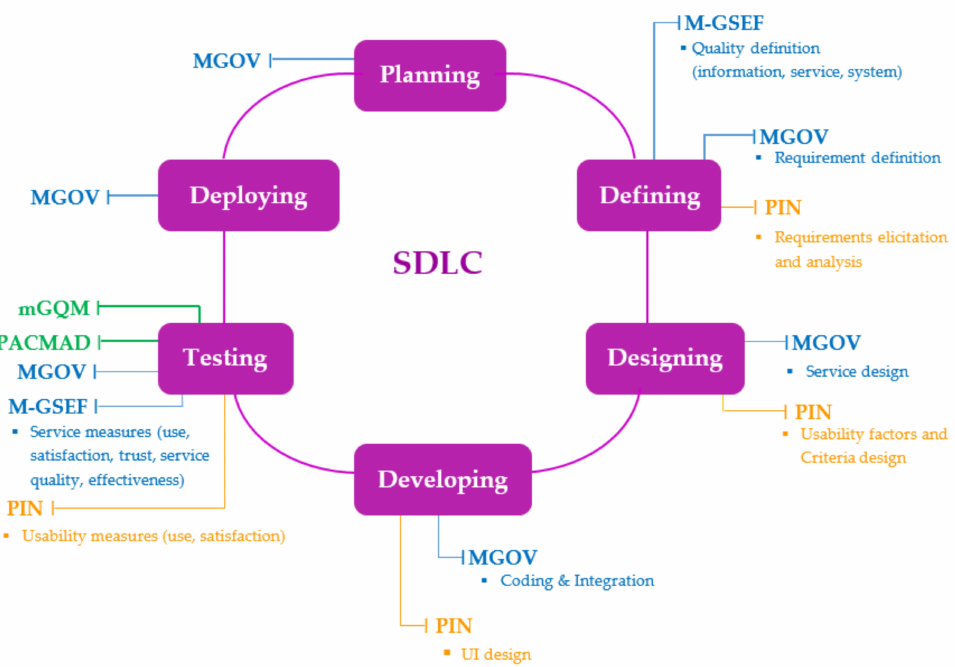
Figure 8. PIN usability design framework, other usability-design-related framework, and